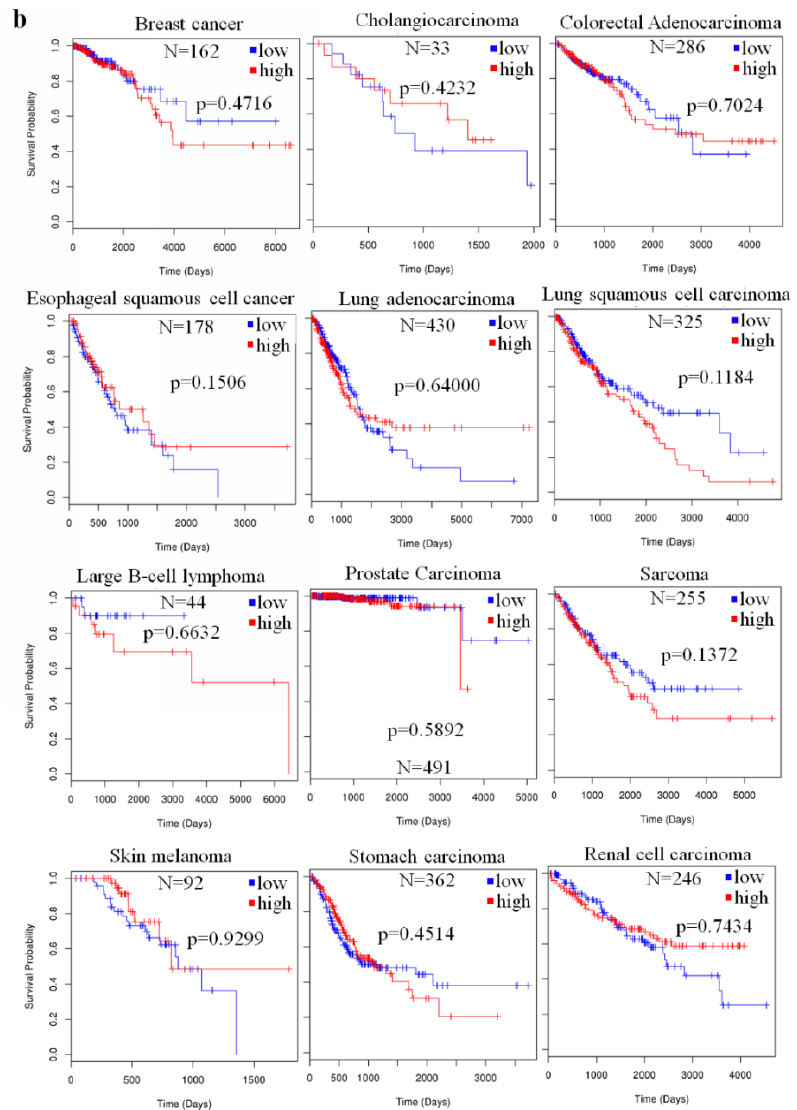
Figure 1. The prognostic value of microRNA-23a (miR-23a) in human cancer. The Cancer Genome Atlas (TCGA) data was retrieved using the Linkedomics platform, and patients were grouped on the basis of the expression of the miR-23a in tumors [67]. ( a ) Shows six cancer types, in which overall survival of patients is significantly correlated with the miR-23a expression; ( b ) shows other cancer types in which overall survival of patients is not significantly correlated with the miR-23a expression though miR-23a is significantly de-regulated in these tumors.